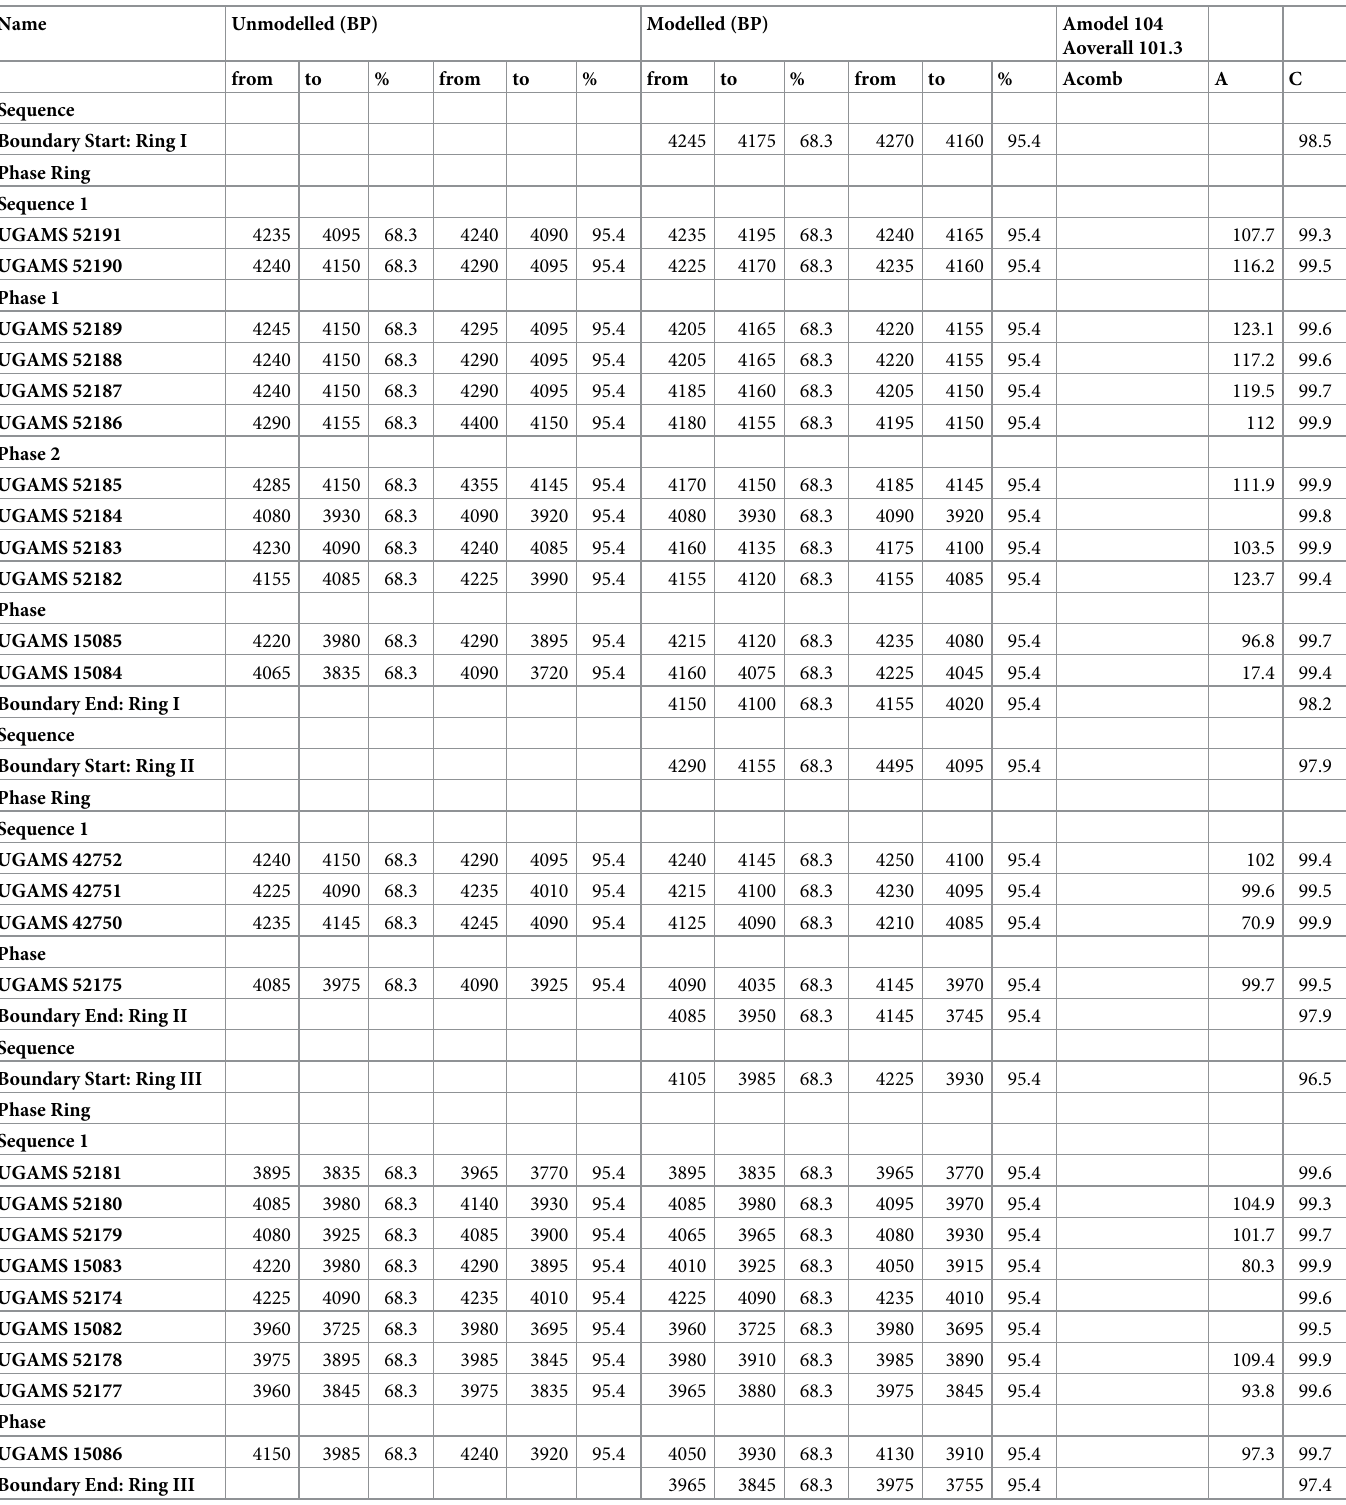
Table 1. Modeled dates from Sapelo Shell Rings I, II, and